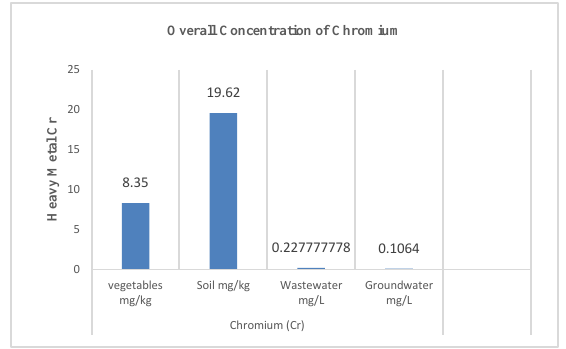
Figure 7: Overall Concentration of Chromium